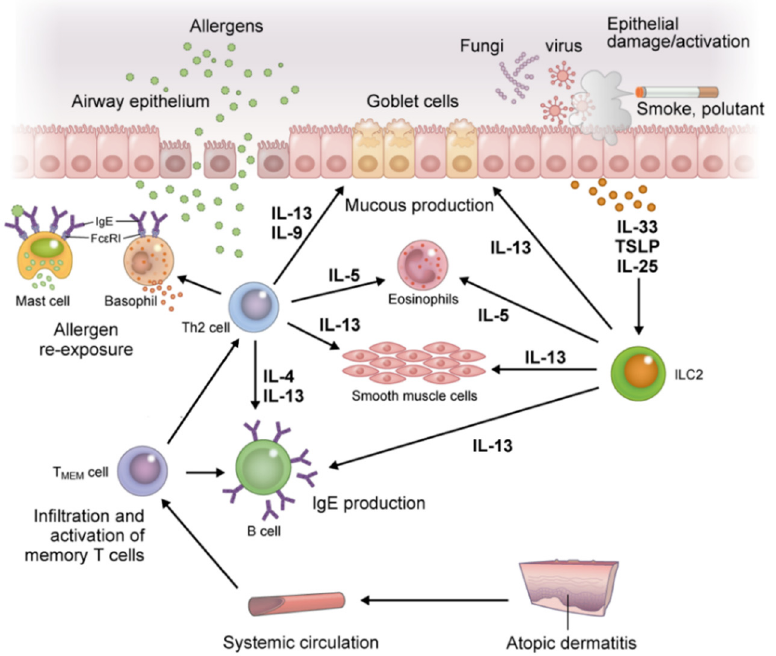
Figure 4. Inflammation in the respiratory tract, a distant organ from the skin in atopic march. Re-exposure to a previously sensitized allergen induces degranulation of inflammatory mediators upon crosslinking of Fc ε RI receptor-bound specific IgE on mast cells and basophils. This induces an immediate-phase reaction and acute inflammation, followed by a late-phase allergic reaction through activation of T MEM cells. The T MEM cells produce IL-4, IL-5, IL-9, and IL-13 in cooperation with ILC2s, and lead to maintenance of allergen-specific IgE levels, eosinophilia, and recruitment of inflammatory cells to inflamed tissue, all of which induce tissue damage and increase mucus production and airway hyperresponsiveness in allergic asthma. Abbreviations: IL, interleukin; ILC2s, group 2 innate lymphoid cells; T MEM , memory allergen-specific T helper 2.